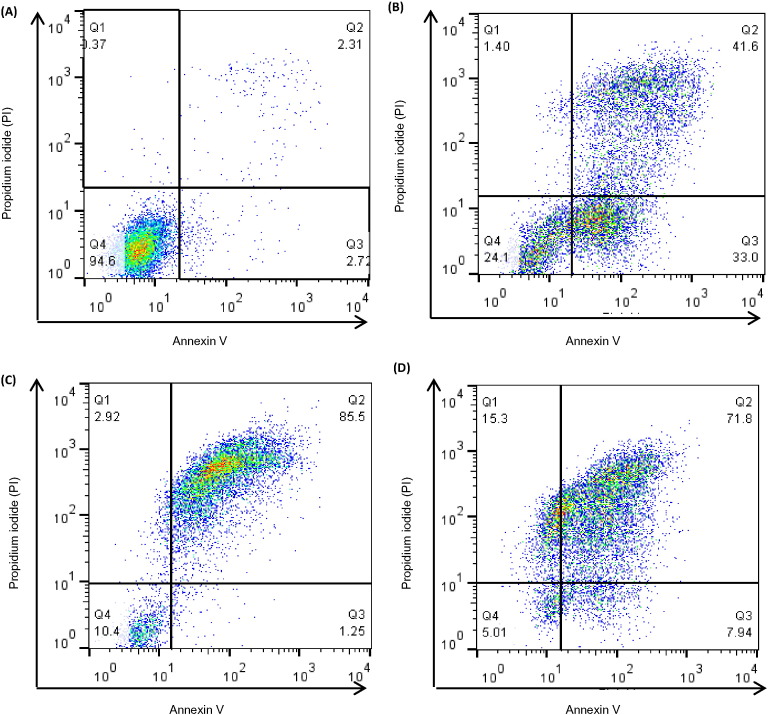
The gating strategy for the characterization of the mechanism of cell death (representative FACS histograms)THP-1 cells were seeded into 24-well plates at 106 cells/mL and cultured for 24 h in serum free RPMI media alone (A), or in the presence of 150 mM NaGlu (B), 200 mM Arg·Glu (C), 200 mM NaCl (D). Following incubation, cells were stained with annexin V-FITC (FL-1 channel) and PI (FL-2 channel) and 10,000 cells were analyzed using a FACSCalibur flow cytometer. Data are displayed as representative quadrant analyses showing the pattern of cytotoxicity for each treatment group; in each case the lower left quadrant represents Annexin V-ve/PI-ve (viable) cells, the lower right quadrant represents annexin V + ve/PI-ve (early apoptotic) cells, the upper right quadrant represents annexin V + ve/PI + ve (late apoptotic) cells and the upper left quadrant represents annexin V-ve/PI + ve (necrotic) cells. The percentage of cells in each quadrant is indicated.